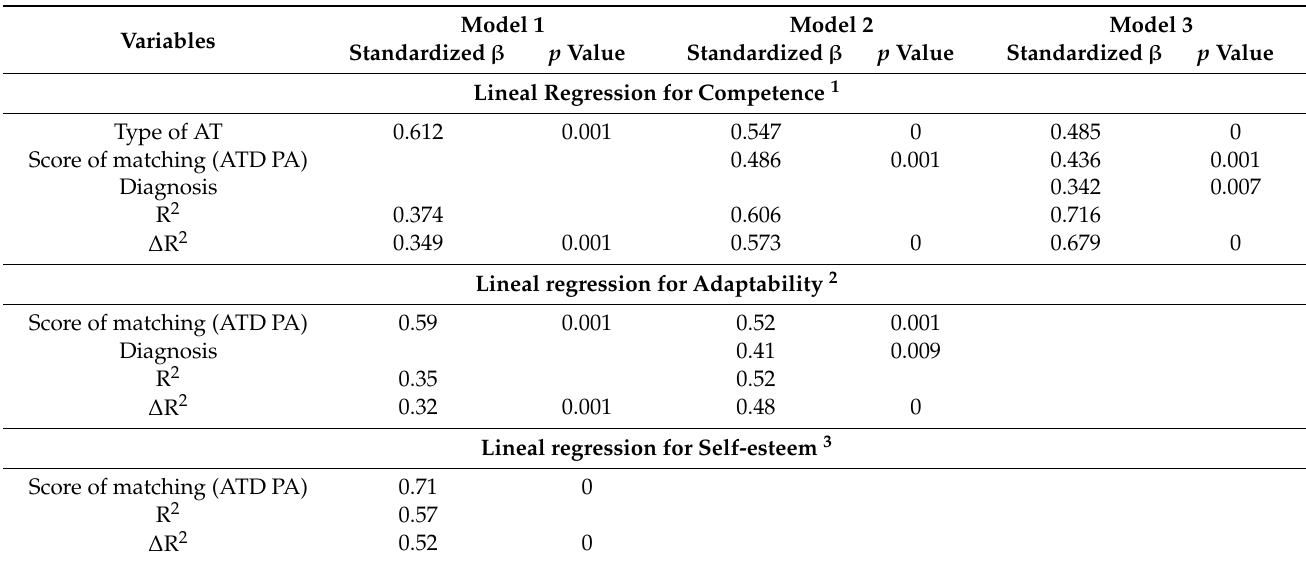
Table 4. Models emerging from lineal regression for dimensions of the